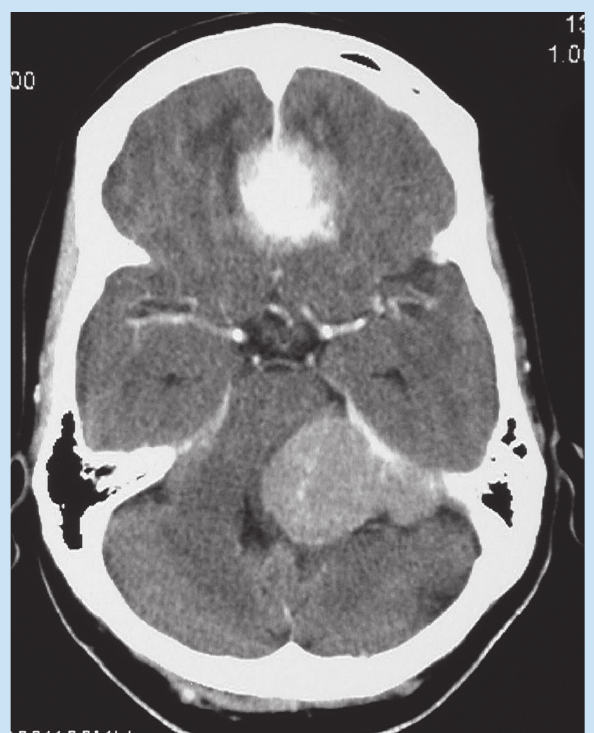
Fig. 2b. Post-contrast image showing contrast-enhanced parasagittal and left cerebellopontine angle